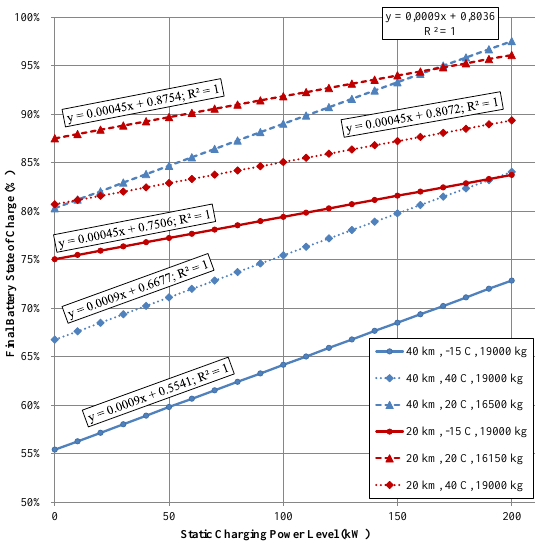
Figure 5. SoC of the battery for different charging powers of the static inductive power transfer (IPT)